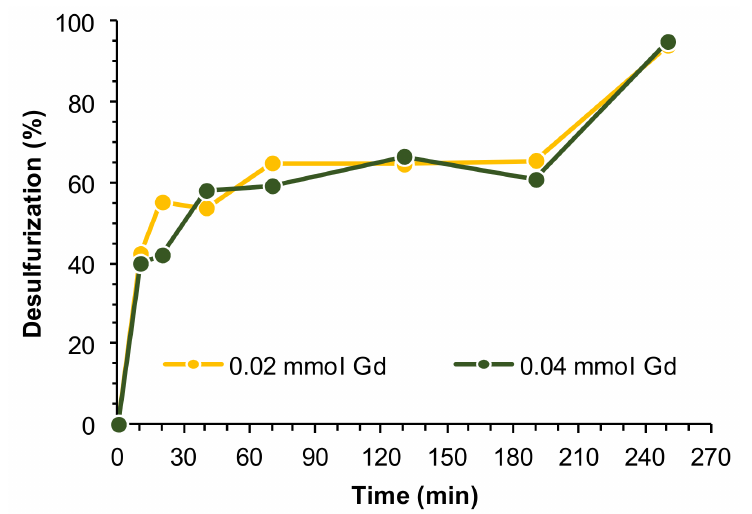
Figure 6. Desulfurization of a multicomponent model diesel catalyzed by different amounts of active centers, i.e., UAV-59@PMMA membrane containing 0.02 or 0.04 mmol of Gd 3+ , using H 2 O 2 as oxidant (0.64 mmol) and [BMIM]PF 6 as the extraction solvent (1:1 diesel:solvent), at 70 ◦ C. The lines connecting experimental points are only for